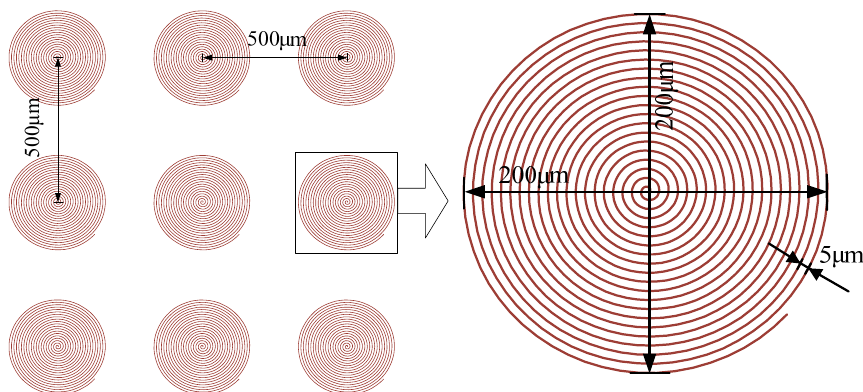
Figure 4. Schematic diagram of the femtosecond laser spiral scanning path.